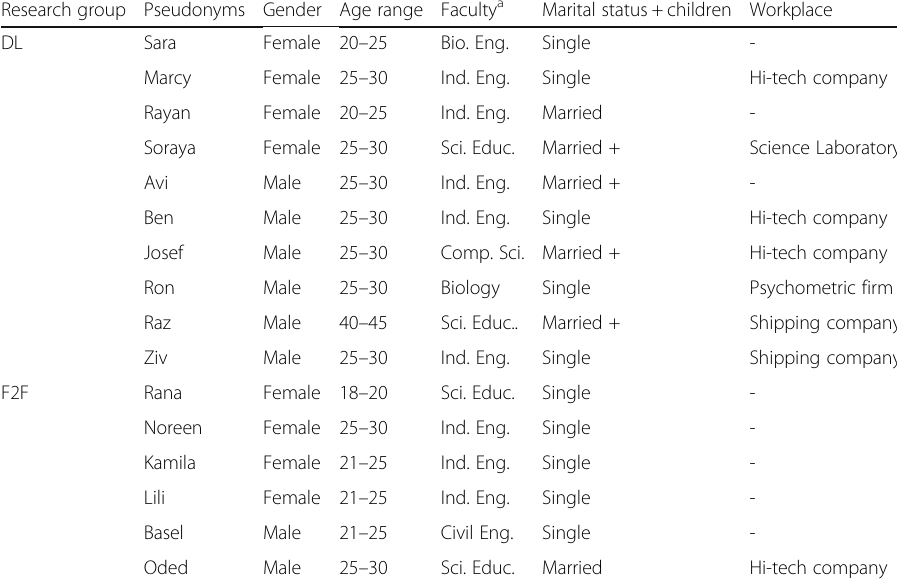
Table 3 Demographic background of F2F and DL science and engineering